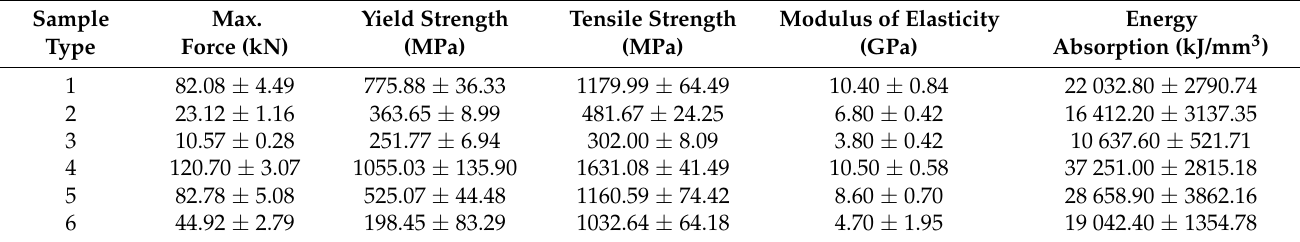
Table 6. Average values of mechanical properties of the tested samples.